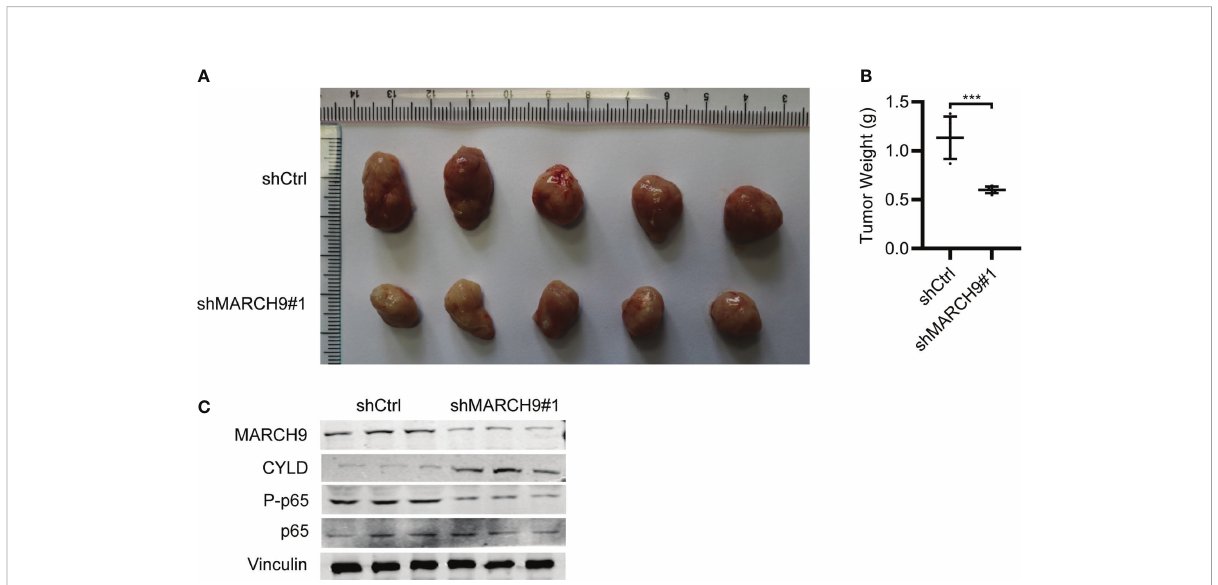
FIGURE 7 MARCH9 knockdown suppressed tumor growth in vivo . (A) Xenograft tumors were excised from BALB/c nude mice on day 45 and compared between sh MARCH9 #1 and shCtrl groups. (B) Tumor weight of BALB/c nude mice between sh MARCH9 #1 and shCtrl groups in statistics. (C) MARCH9, CYLD, P- p65 and p65 expression in xenograft tumor tissues between sh MARCH9 #1and shCtrl groups by western blotting. *** P <